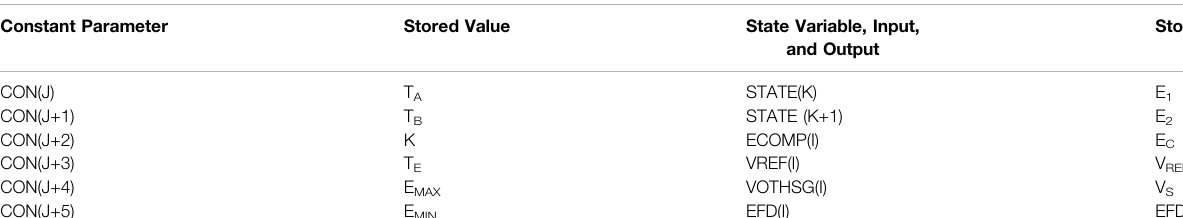
TABLE 2 | Storage allocation of array for SEXS.